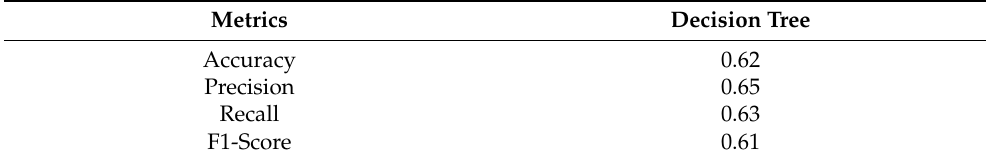
Table 3. Assessment with DT classification.